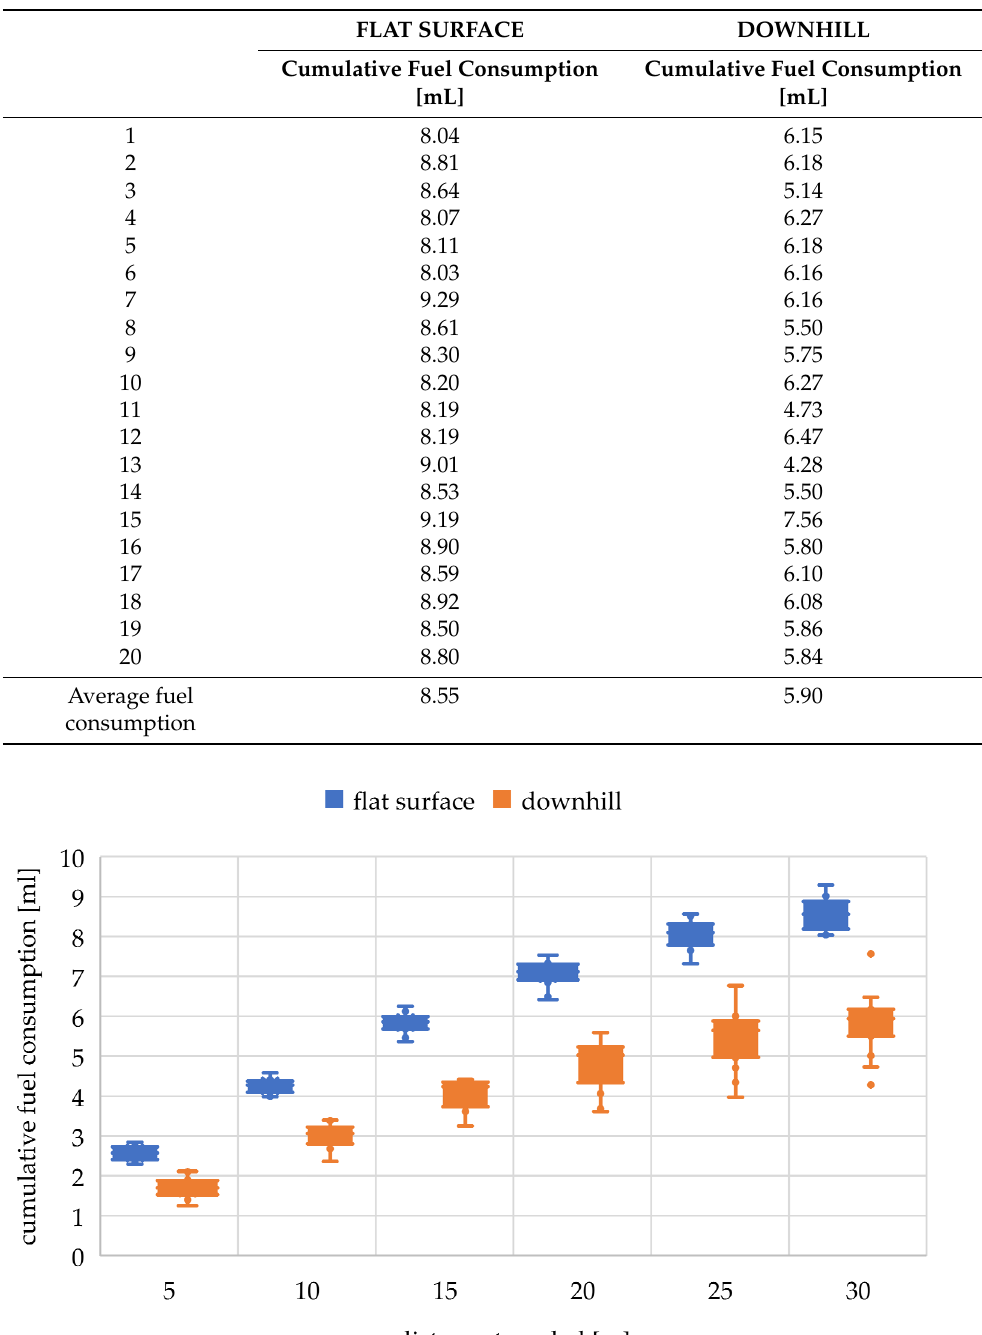
Table 3. Cumulative consumption during individual starts of the vehicle. Source: author.